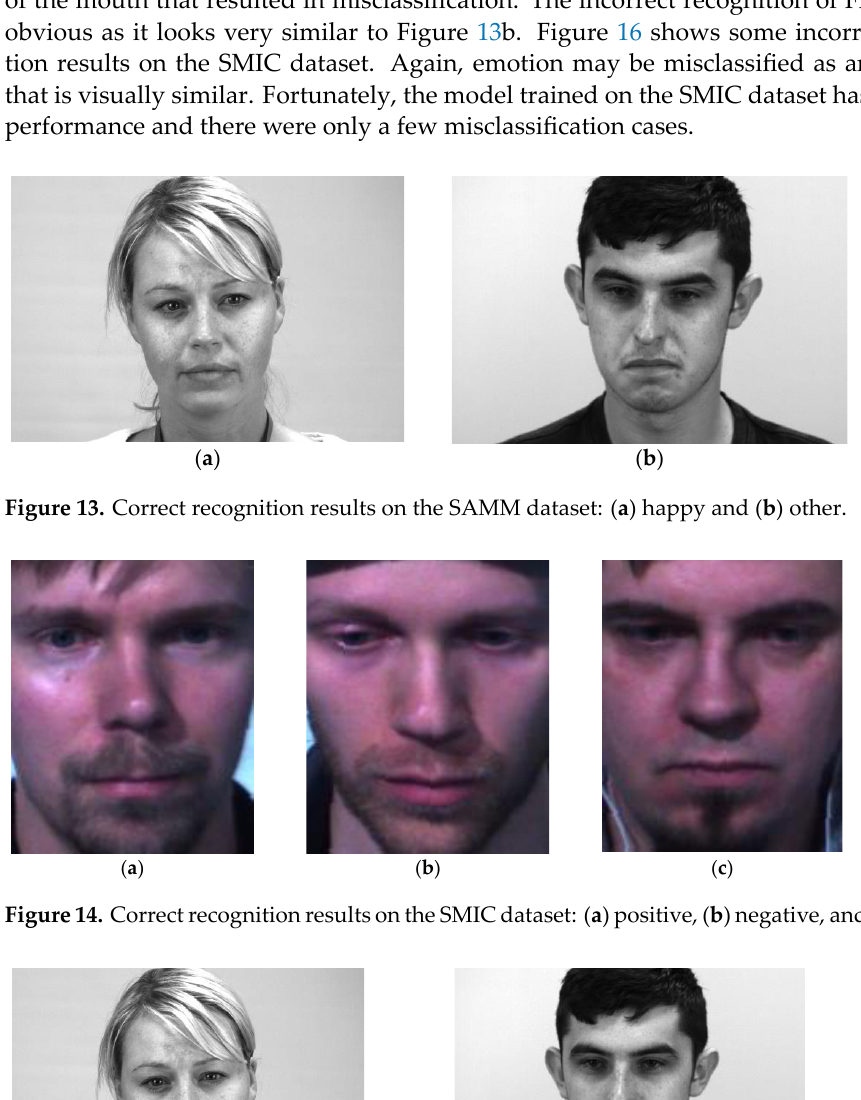
( c ) Figure 16. Incorrect recognition results on the SMIC dataset: ( a ) positive predicted as negative, ( b ) negative predicted as surprise, and ( c ) surprise predicted as negative. 5. Ablation Studies We performed ablation studies on EVM and the loss function. Some hyperparameters were selected for experimentation. First, we compared the performance of DS-3DCNN with or without using EVM. Table 7 shows the results of DS-3DCNN without using EVM on the two datasets. Without domain adaptation, utilizing EVM to amplify the facial mo- tion leads to a slight improvement in accuracy (e.g., 1.6% on SAMM). With domain adap- tation, the effect of EVM is more significant. Improvement is seen in all evaluation metrics. Utilizing EVM leads to a 4% improvement in SAMM and a 5% improvement in SMIC. Table 7. Performance of DS-3DCNN with and without using EVM. Model